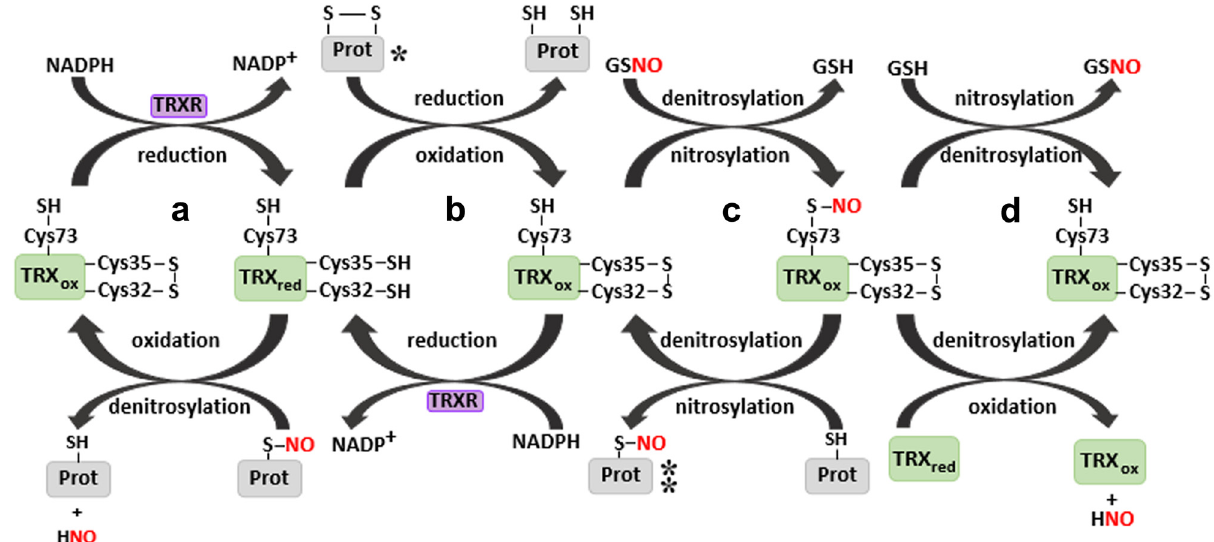
Figure 2: General mechanism of redox reactions and of transnitrosylation: TRX1 reduces its target proteins ( b ) , TRX1 is reduced by TRXR at the expense of NADPH ( a and b ) . TRX1 can reduce many targets ( * ) , such as peroxyredoxins ( PRX ) , the ASK1, the nuclear factor kappa - light - chain - enhancer of activated B cells ( NF - κ B ) , and interleukin 4 ( IL - 4 ) . The oxidized TRX1 denitrosylates the nitrosylated glutathione ( GSNO ) releasing reduced GSH forming an oxidized - nitrosylated TRX ( c ) . The latter returns to its denitrosylated form through the reaction with